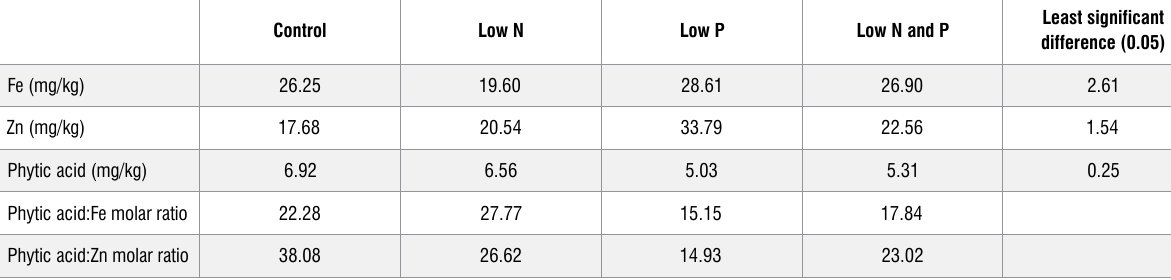
Average values of two cultivars for the measured nutritional traits over two years separated by treatments Control Low N Low